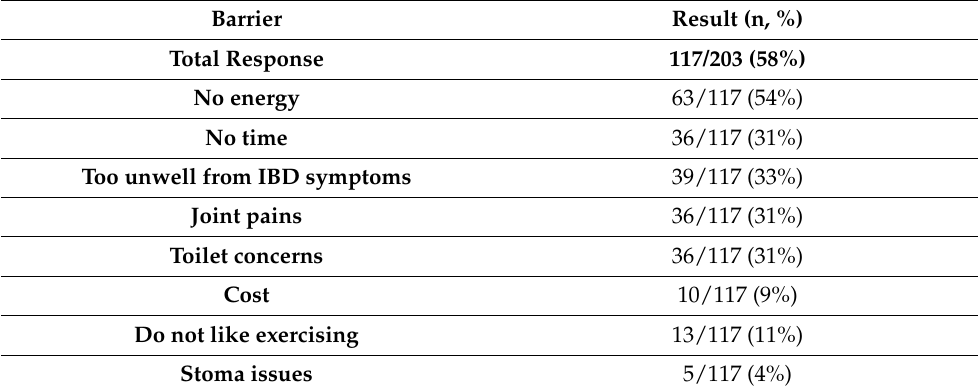
Table 2. Results of barriers to